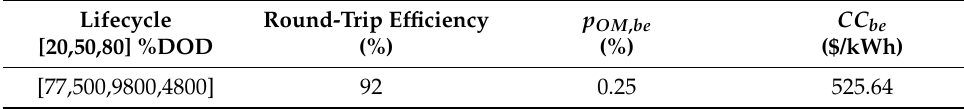
Table 7. Battery specifications—Lithium ion